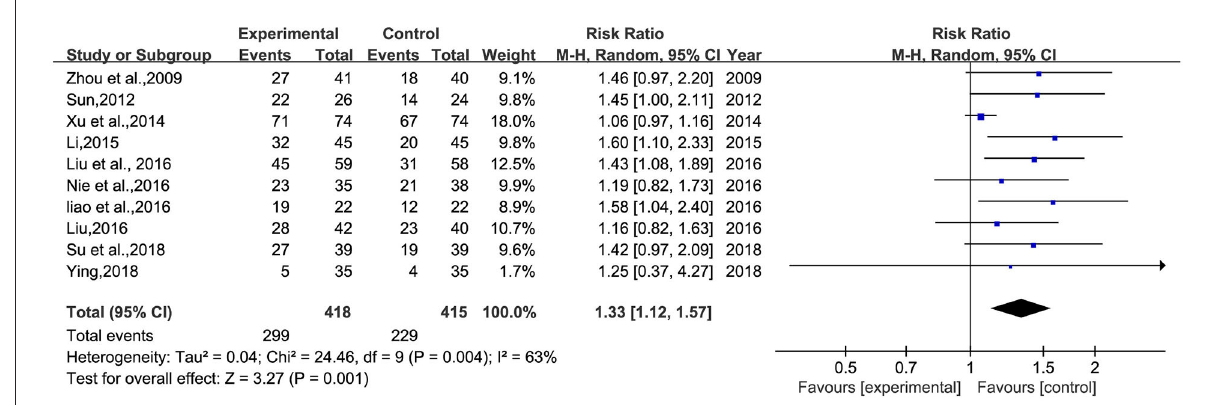
FIGURE5 Meta-analysis of BHD and antidepressant drugs regarding total clinical effectiveness. Blue: Dichotomous.